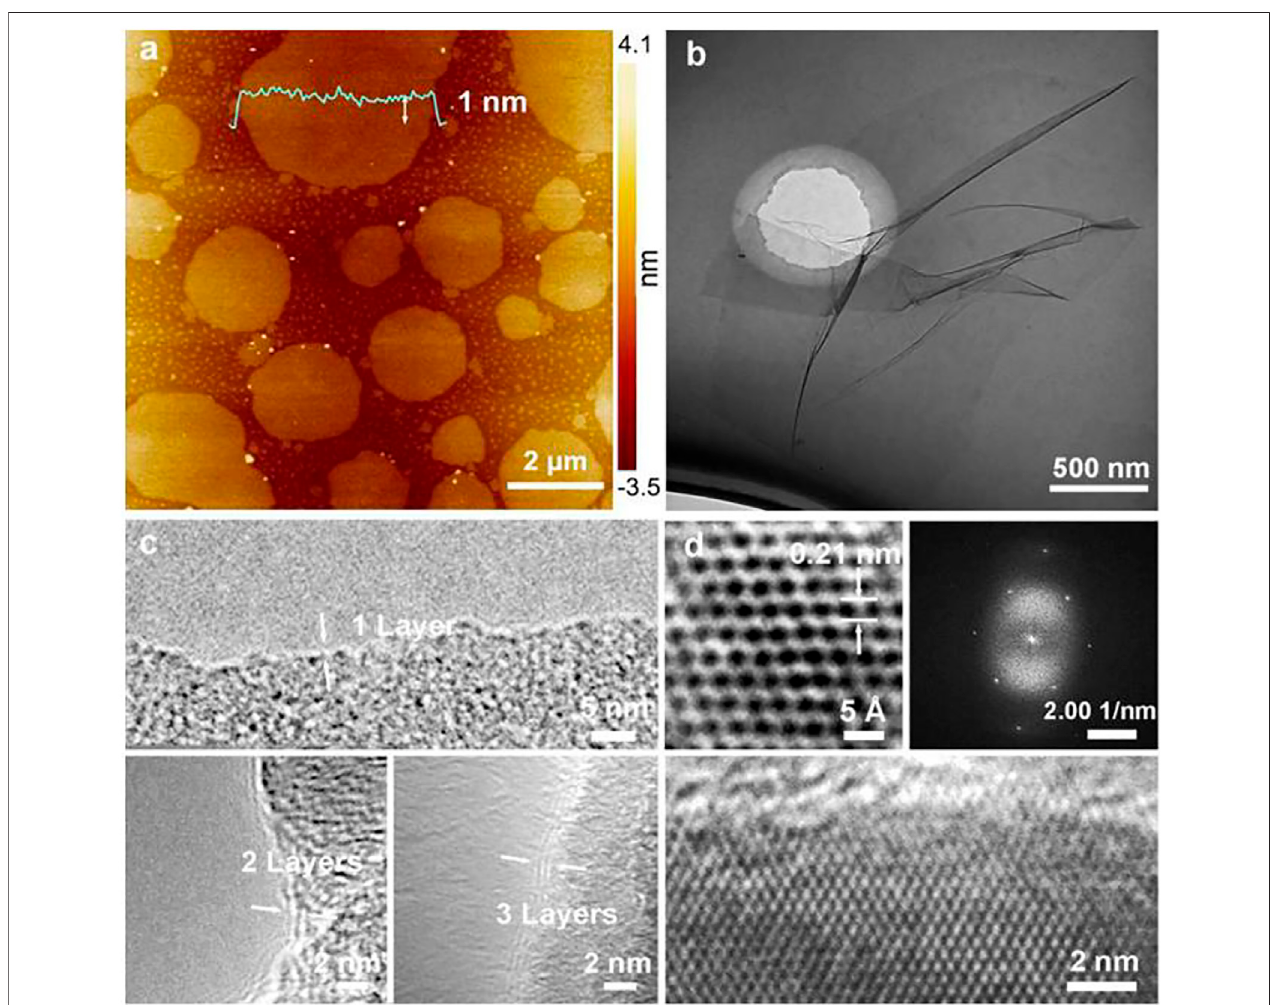
FIGURE 8 | (A) and (B) The AFM and TEM images of black liquor-converted graphene (BL-G) sheets, (C) the HRTEM image of BL-G sheets with 1 – 3 layers, (D) top :Theatomicallyresolved HR-TEMimage (left) andselectedareaelectron diffractionpattern (right) toshowthewell-ordered honeycomblatticestructure withlattice spacingof0.21 nm. Bottom :Themagni fi edHRTEMimagesindicatedalargeareawell-orderedgraphenelattice.The fi gureisreprintedwithpermissionfromDingetal., 2020, Copyright 2020, Elsevier.